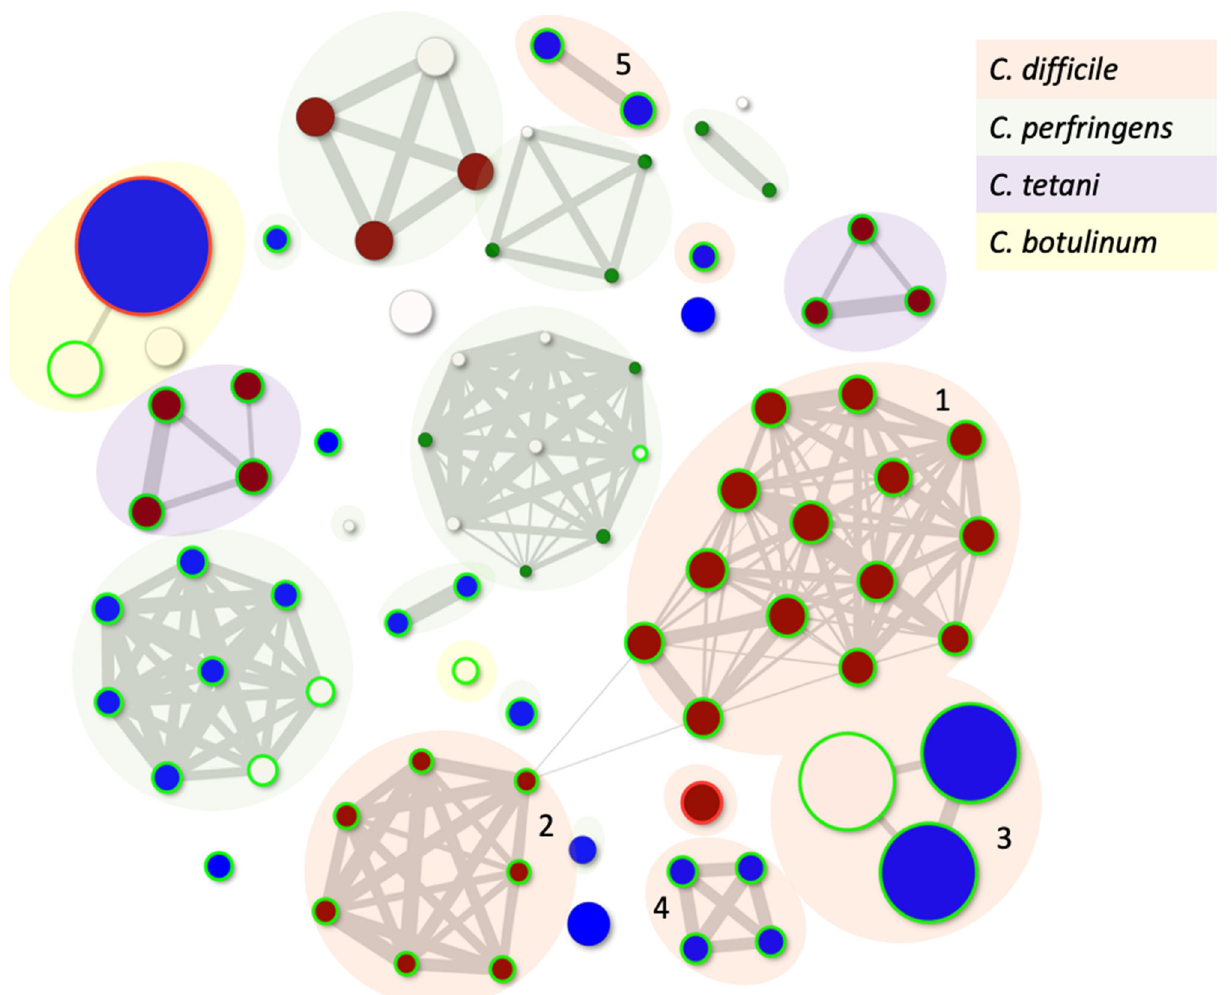
Figure 1. Genetic relationships between all known Clostridial phages that can either independently plaque on bacterial hosts or can be induced from their host strain. The size of the dot is related to the genome size, and the colour is reflective of the morphology with red being a myovirus, blue siphovirus and white where the taxonomy is unknown. The green circle suggests the phages are temperate using Phage Leads, and the red circle shows that the phage carries an antibiotic resistance gene. Clouds numbered 1–5 represent clusters of C. difficile phages (Table S1). Phages included in the analysis are listed in Table S1.